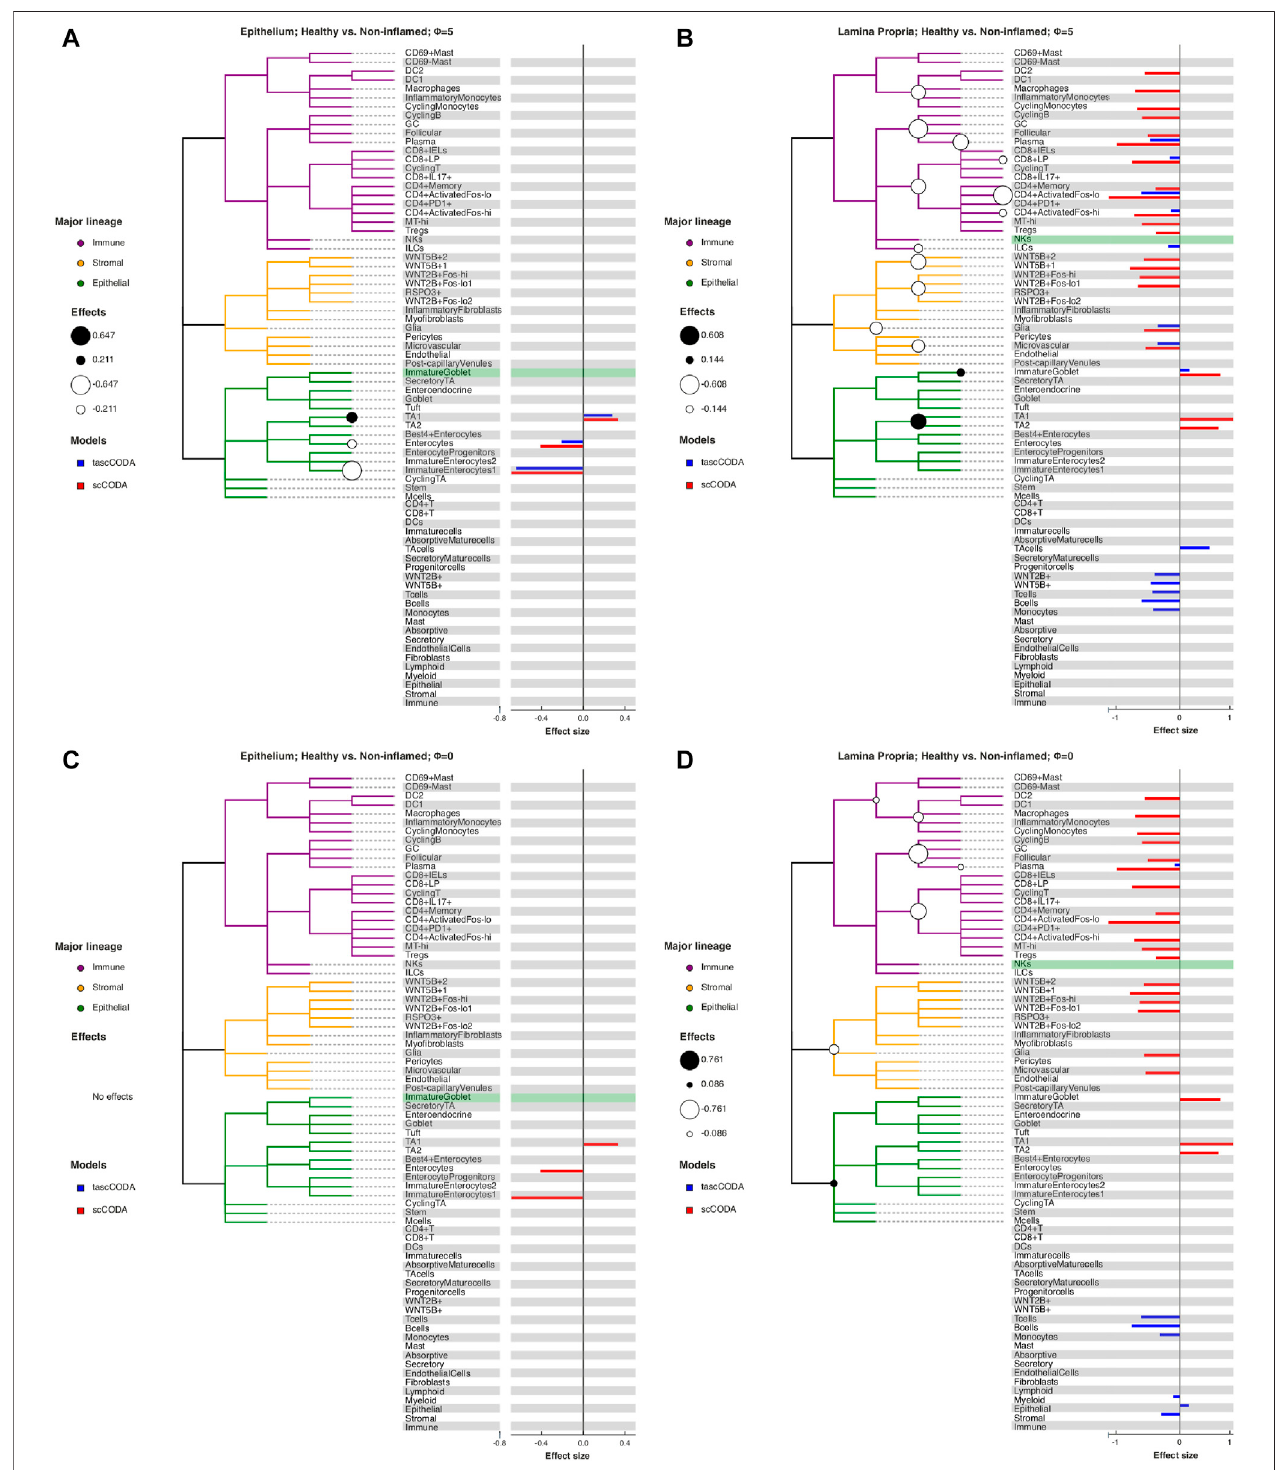
FIGURE5| BehavioroftascCODAonscRNA-seqdatafordifferentvaluesof ϕ .Allplotsshowthecomparisonofhealthycontrolsamplestonon-in fl amedtissuesamplesofUC patientsinthedatafromSmillieetal.(2019).WhiteandblackcirclesonthecelllineagetreeshowtheeffectsfoundbytascCODA,whicharealsoshownasbluebarsontherightsideof eachplot.Thebarsbelowthetreedepicteffectsoninternalnodes,withlowerpositionsinthediagramcorrespondingtonodesclosertotheroot.Forcomparison,theredbarsindicate effects found byscCODA,which onlyoperates on the tipsofthetree. The green-shadedareashowsthereference celltypethatwas used for both models. (A) When ϕ (cid:2) 5, tascCODAprefersplacingeffectsnearthetipsofthetreeand fi ndstheexactsamesolutionasscCODAfortheEpitheliumdata. (B) IntheLaminaPropria,tascCODAplacessome effectsoninternalnodes,resultinginasparsersolutionthantheoneobtainedbyscCODA(14vs.21credibleeffects). (C) When ϕ (cid:2) 0,tascCODA fi ndsnocredibleeffectsinsamples from the Epithelium, and (D) only seven effects are necessary to summarize the large number of effects found by scCODA when looking at samples from the Lamina Propria.